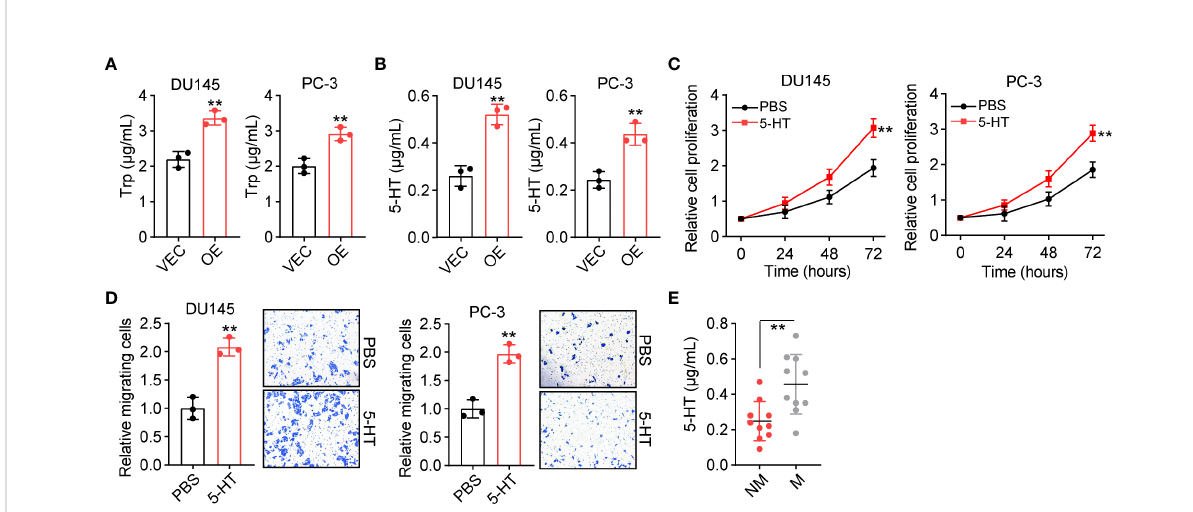
FIGURE 2 TPH1 promotes tryptophan (Trp) hydroxylation and 5-hydroxytryptamine (5-HT) production. (A) Culture of 10 5 DU145/PC-3 and TPH1- overexpressing DU145/PC-3 cells in 2 ml of culture medium for 48 h. Trp consumption was examined using a human Trp enzyme-linked immunosorbent assay (ELISA) kit. (B) 5-HT production in (A) was examined using a human 5-HT ELISA kit. (C) Relative proliferation of DU145/PC-3 cells treated with phosphate-buffered saline (PBS) or 5-HT (5 m M). (D) Relative number of migrating DU145/PC-3 cells treated with PBS or 5-HT (5 m M). (E) Quanti fi cation of 5-HT in tumor tissues from patients with M and NM prostate cancer (n = 10 per group) using ELISA. ** p <